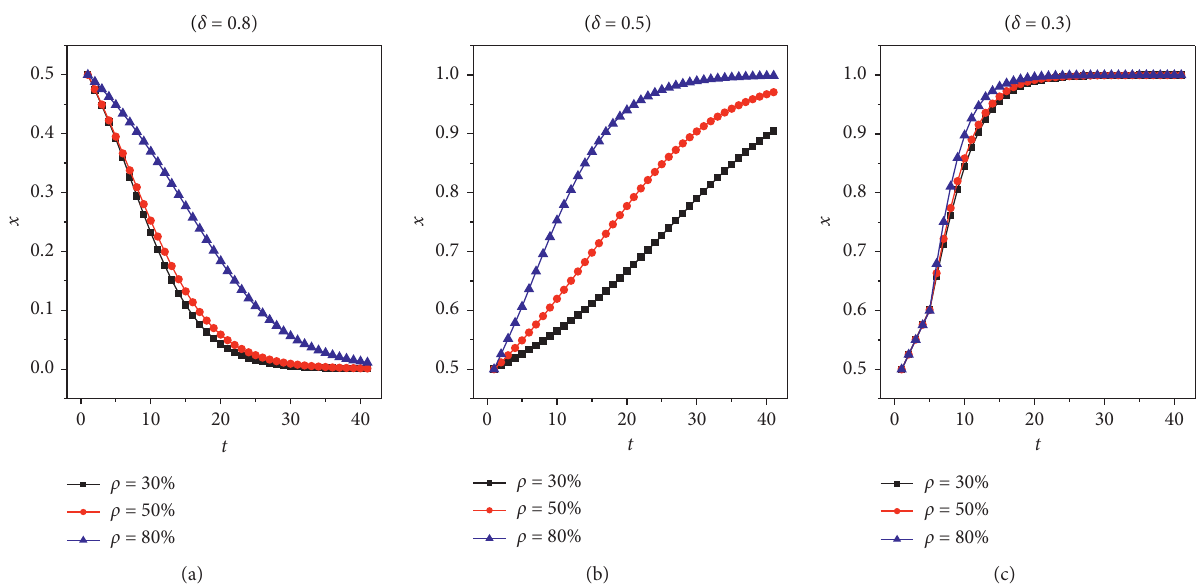
Figure 6: The proportion of innovation-leading firms in the group for different patent fee intensity ρ on three levels of the innovation risk δ based on the basic game